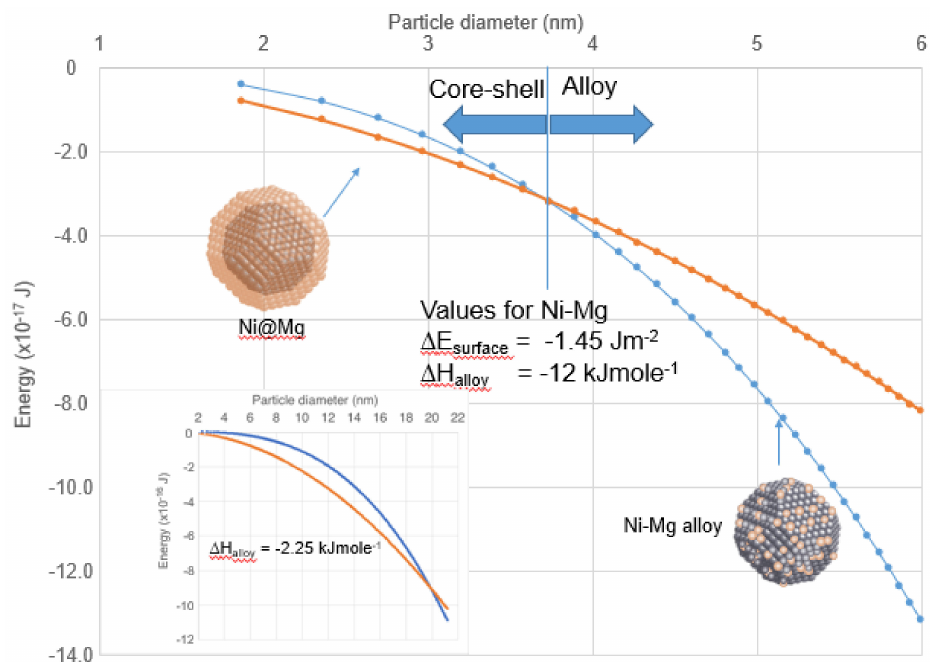
Figure 11. The size dependence of the enthalpy of mixing, assuming the molar value stays constant (blue line), and the difference in surface energy between the core–shell and alloy structures (red line), with values appropriate for bulk NiMg with a 50/50 concentration. It is assumed that the surface energy of the alloy is the average of the Ni and Mg values. Below a critical size (3.7 nm) the core–shell structure has lower energy. The inset shows the calculation repeated for a reduced enthalpy to shift the critical size to 20 nm core–shell particles observed experimentally